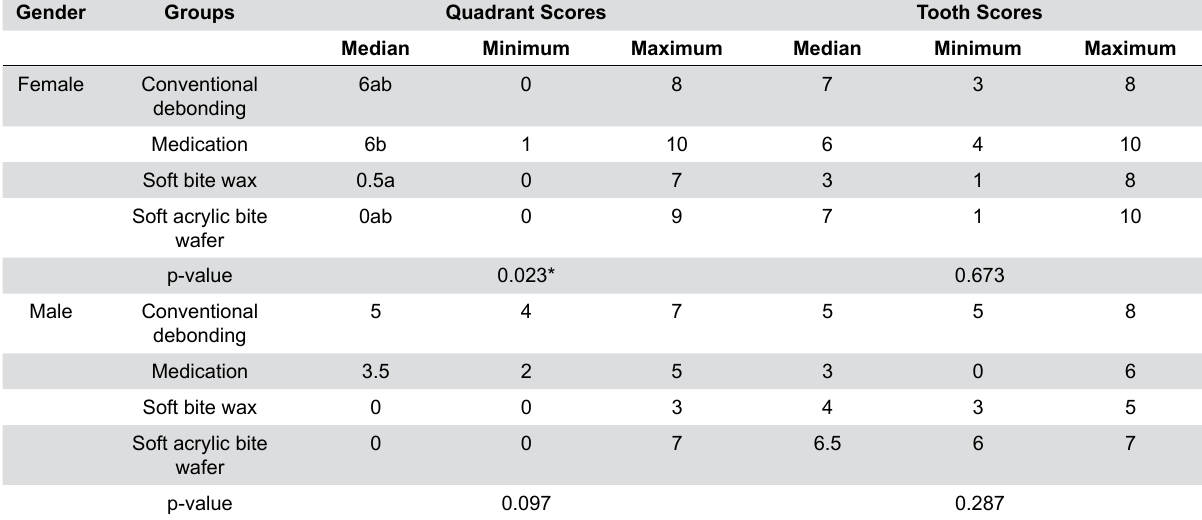
Table 5- Distribution of Numerical Rate Scale (NRS) scores in Table 4 according to gender and their independent between-groups comparisons in female and male